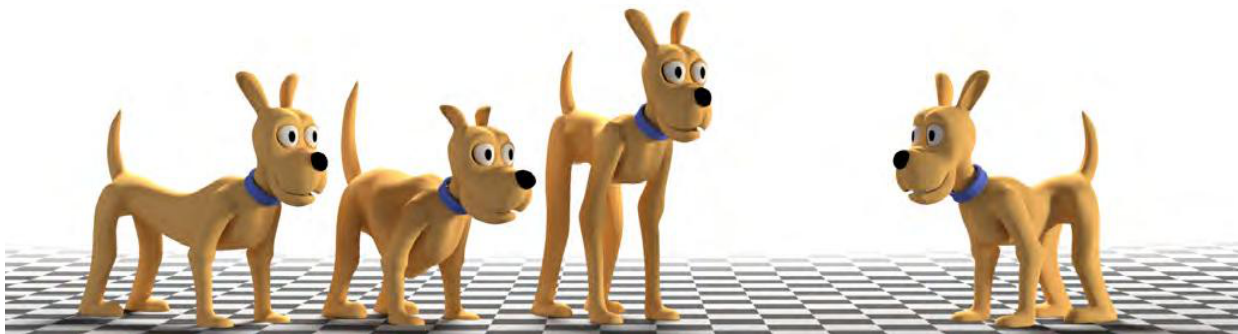
Fig. 1 Anisotropic deformation paradigm enables directionally aligned modeling without the need for a rig. The original model (right) was edited part-wise to change shape characteristics, such as the length and thickness of legs, body, ears, or tail